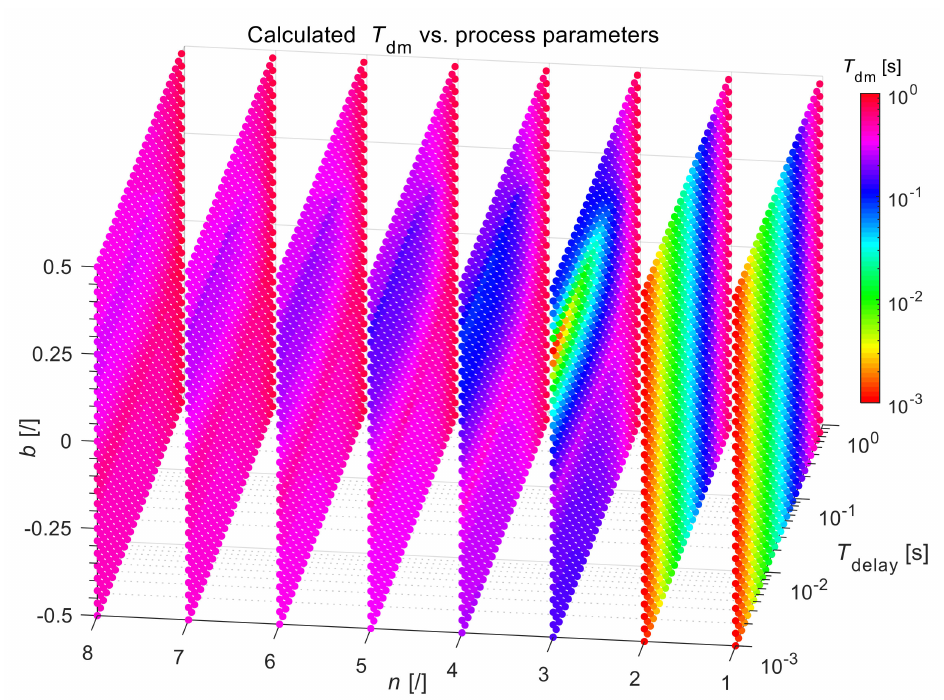
Figure 4. The calculated time delays T dm for process G P1 (s) parameters perturbation. The IAE criterion values for the process G P1 are shown in Figure 5. The IAE criterion is 0 for the first- and the second-order processes (perfect fit), and it increases as the process order and numerator time constant b increase. However, the maximum value of IAE remains relatively low (0.068).